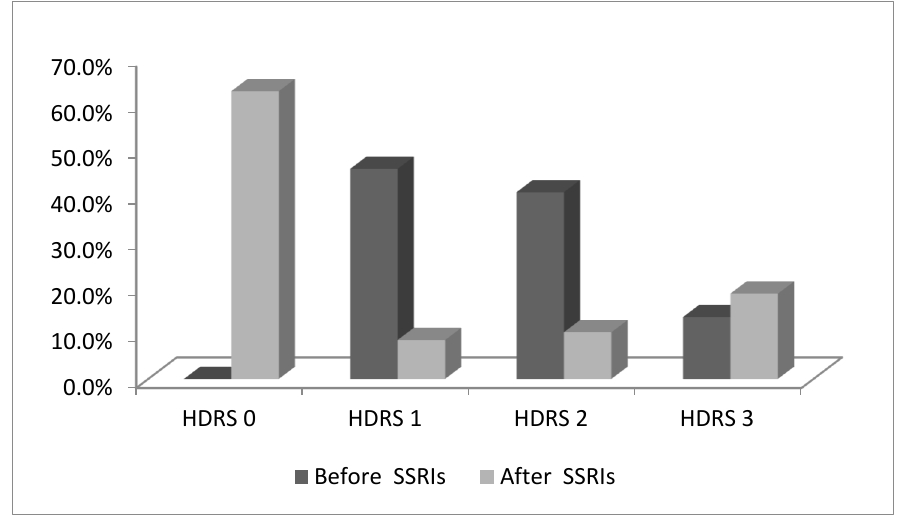
Figure 1. Effect of SSRIs on stage II COPD.